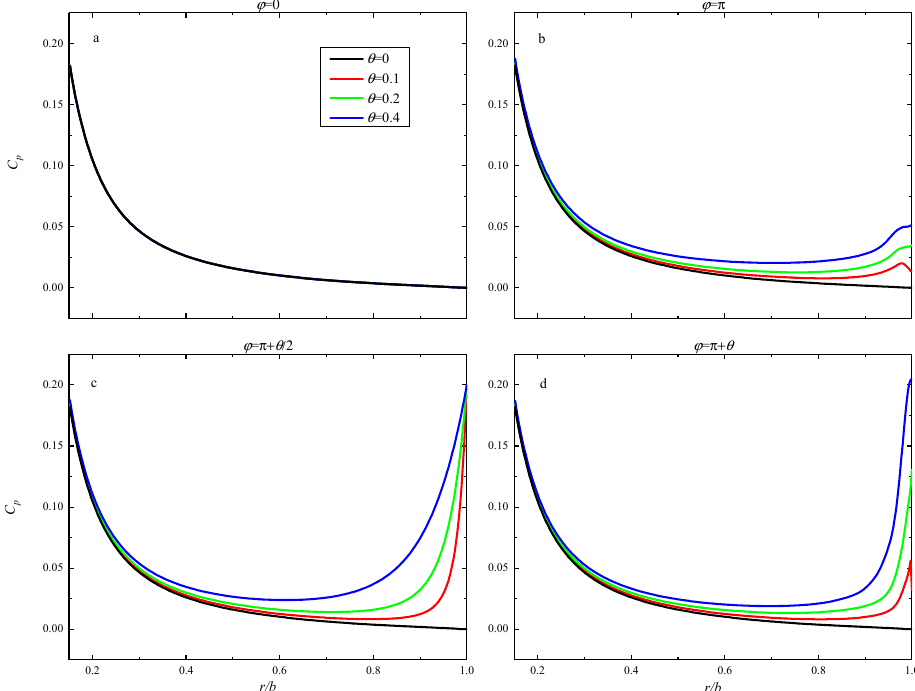
Figure 21. Pressure coefficient for C w = 10,137, Re ϕ = 5.12 × 10 5 , E = 0.2, at plane z / s = 0.5: ( a ) φ = 0, ( b ) φ = π , ( c ) φ = π + θ /2, ( d ) φ = π + θ